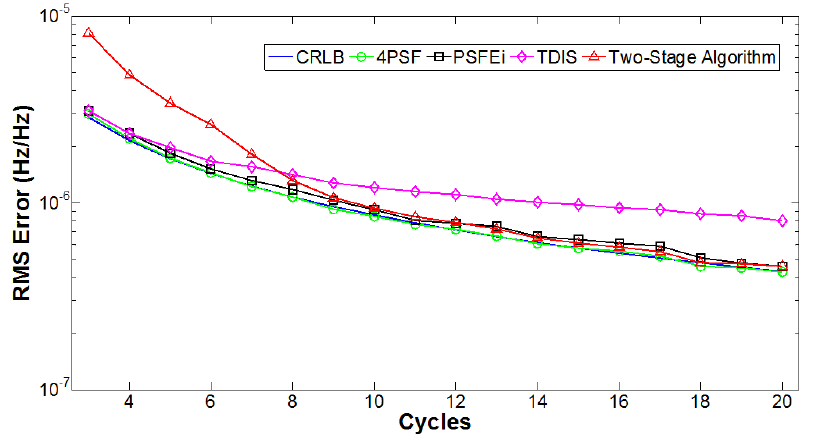
Figure 2. RMS error of frequency estimation with an increasing number of cycles in the data window.